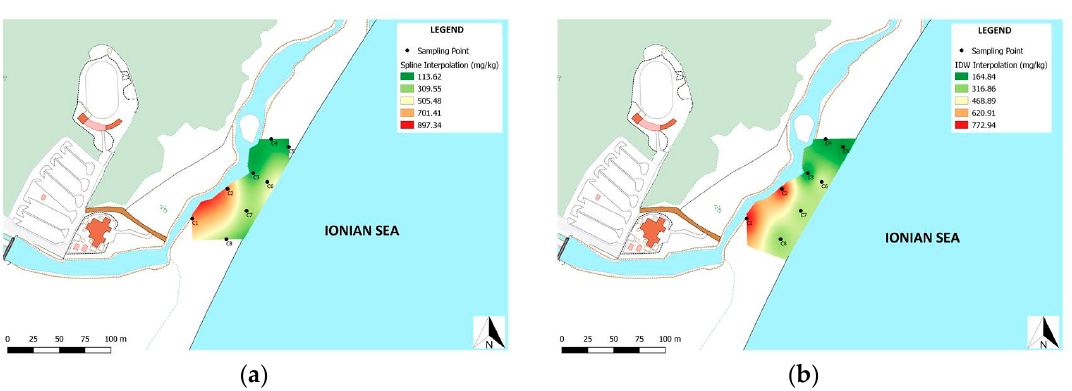
Figure 7. ( a ) Spline interpolation; ( b ) inverse distance weighted (IDW) interpolation.